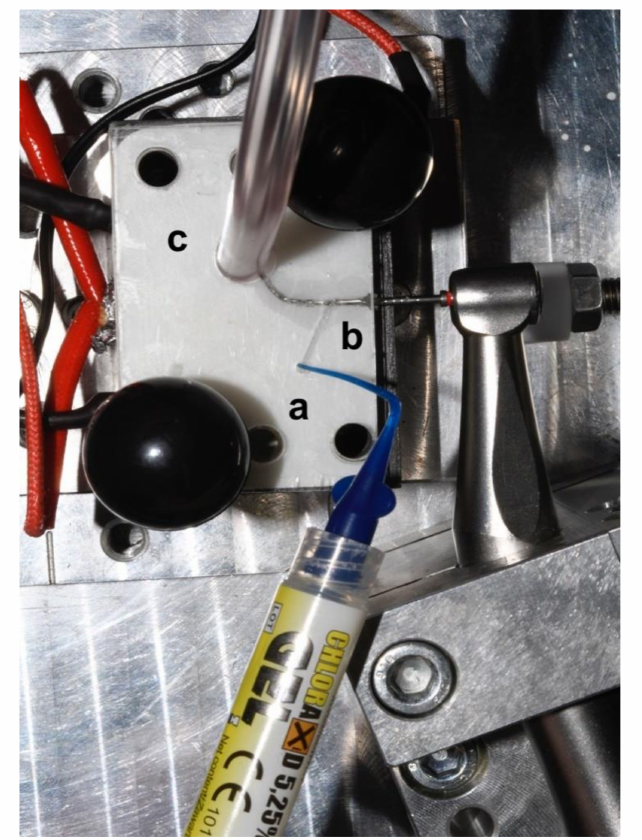
Figure 2. A detail of device with a F6 SkyTaper (F6ST) instrument exposed to NaOCl gel. ( a )